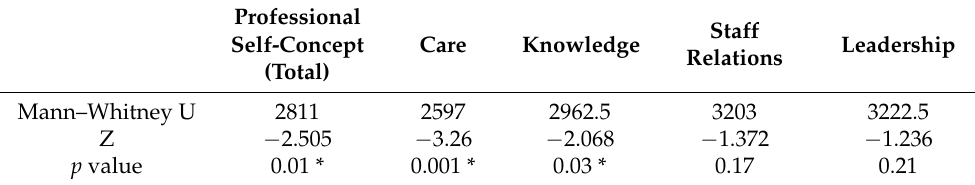
Table 4. Differences in professional self-concept and its subdimensions based on exposure to COVID- 19